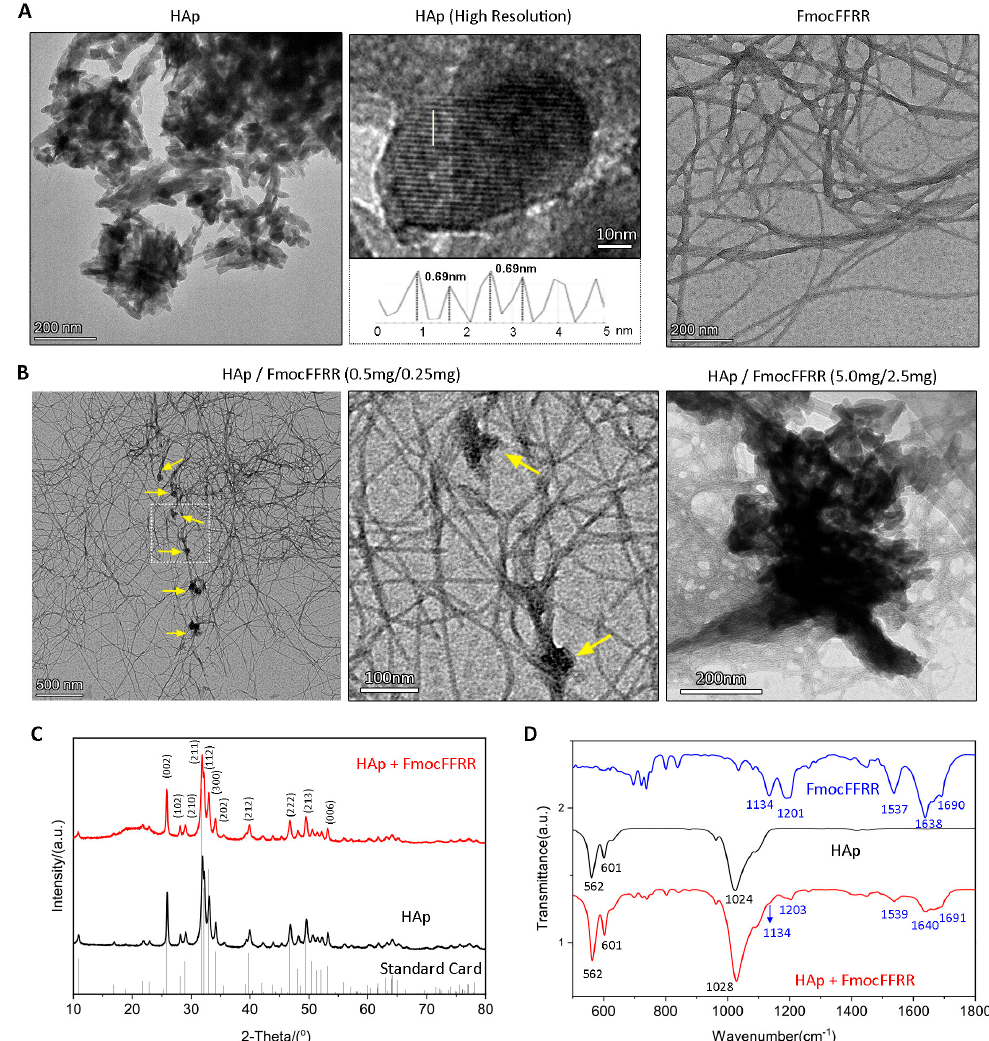
Figure 4. ( A ) TEM images of HAp particles (5.0 mg/mL) with high-resolution image (middle panel) showing lattice spaces. The gray value distribution curve of indicated white light was also showed to indicate the interlamellar distance. TEM image of FmocFFRR assembly (2.5 mg/mL) was shown at the right panel. ( B ) TEM images of HAp/FmocFFRR hydrogel at the concentration of 0.50/0.25 (mg/mL) or 5.0/2.5 (mg/mL) in Tris buffer. Yellow arrows indicated peptide-bound HAp particles. ( C ) XRD patterns of free HAp particles (black) and the lyophilized HAp/FmocFFRR sample (red). A standard card of the calculated XRD pattern of HAp was also shown for comparison. ( D ) FTIR spectra of FmocFFRR (blue), HAp (black), and HAp/FmocFFRR (red). FT - IR spectra were further conducted to demonstrate the molecular interaction be- tween HAp and FmocFFRR. The results (Figure 4D) showed that the phosphate stretching vibration at 1024 cm − 1 of HAp slightly shifted to 1028 cm − 1 after anchoring of FmocFFRR. Slight shifts of guanidine groups vibration (1537 cm − 1 ) and amide bands (1638 cm − 1 and 1690 cm − 1 ) of FmocFFRR after HAp/FmocFFRR interaction were also observed. The inten- sity of the amide I band at 1690 cm − 1 assigned as β - turn [29] of FmocFFRR assembly in- creased after HAp/FmocFFRR interaction compared to the amide II band internally at 1638 cm − 1 , in accordant with our previous finding on FmocFFRRR/CaP minerals